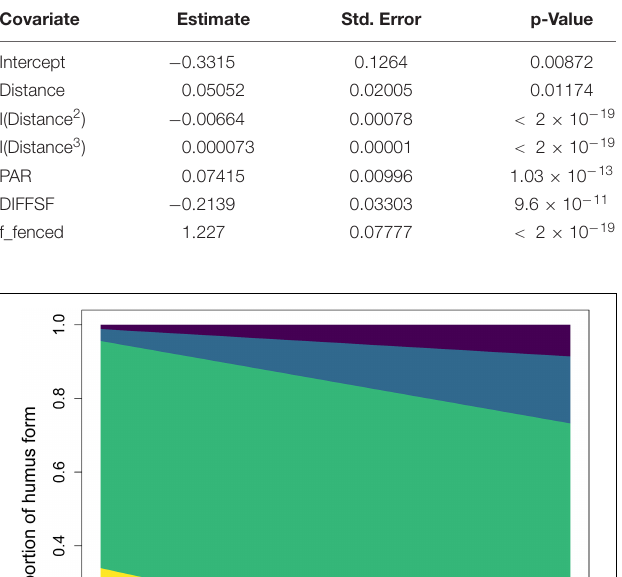
TABLE 2 | Results of the inhomogeneous replicated Poisson point process model with coefficients, standard errors, and p-values.